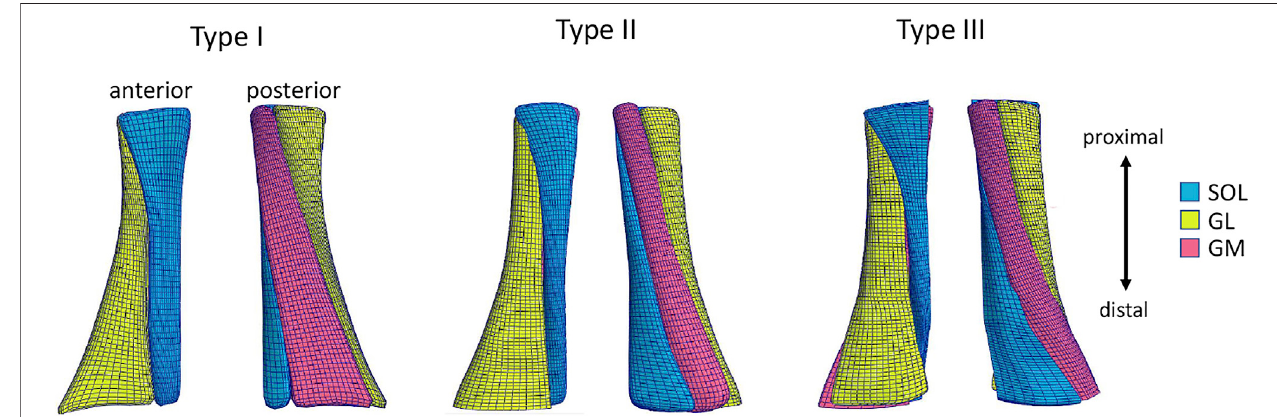
FIGURE 1 | Anterior and posterior view of the Achilles free tendon geometries representing the three types of twist: Type I (least), Type II (moderate), Type III (extreme). Each 3D tendon model was divided in three sub-tendons, each one arising from one of the three triceps surae muscles: the soleus (SOL) and the two heads (medialis, GM and lateralis, GL) of the gastrocnemius